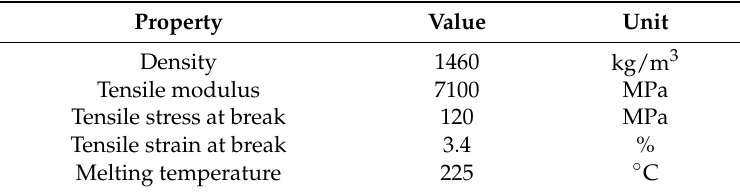
Table 1. Material properties of the investigated polybutylene terephthalate reinforced with 20 wt % of